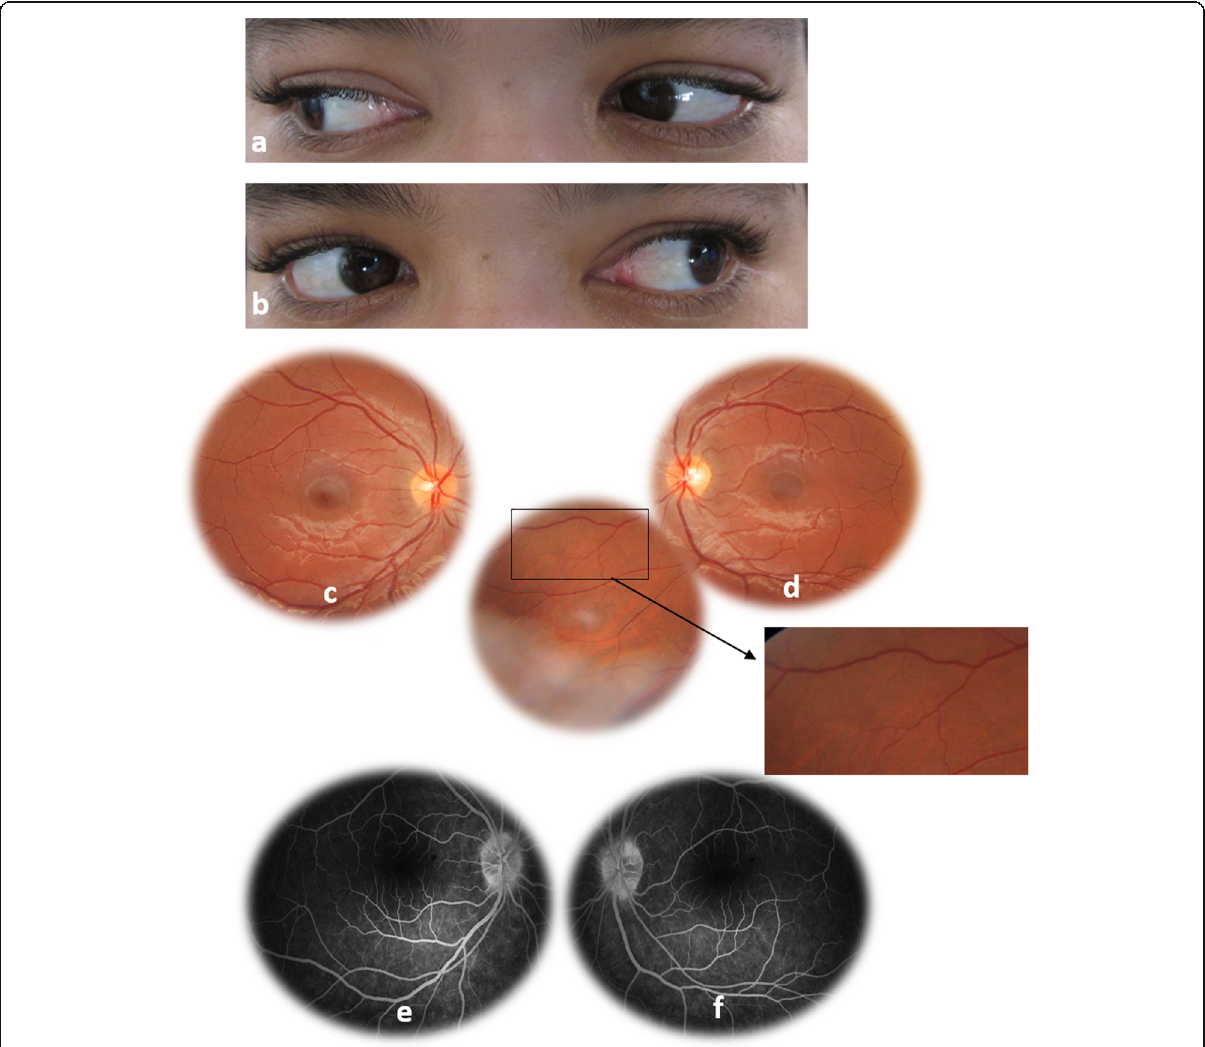
Fig. 3 a , b Photography of the ocular motility examination, two weeks after initiation of doxycycline therapy, reveals recovery of the left lateral rectus motility ( b ) . c , d Fundus photography showing the complete resolution of optic dis swelling, retinal hemorrhages, and retinal infiltrate. e , f Late-phase fundus fluorescein angiography showing the resolution of optic disc leakage in both